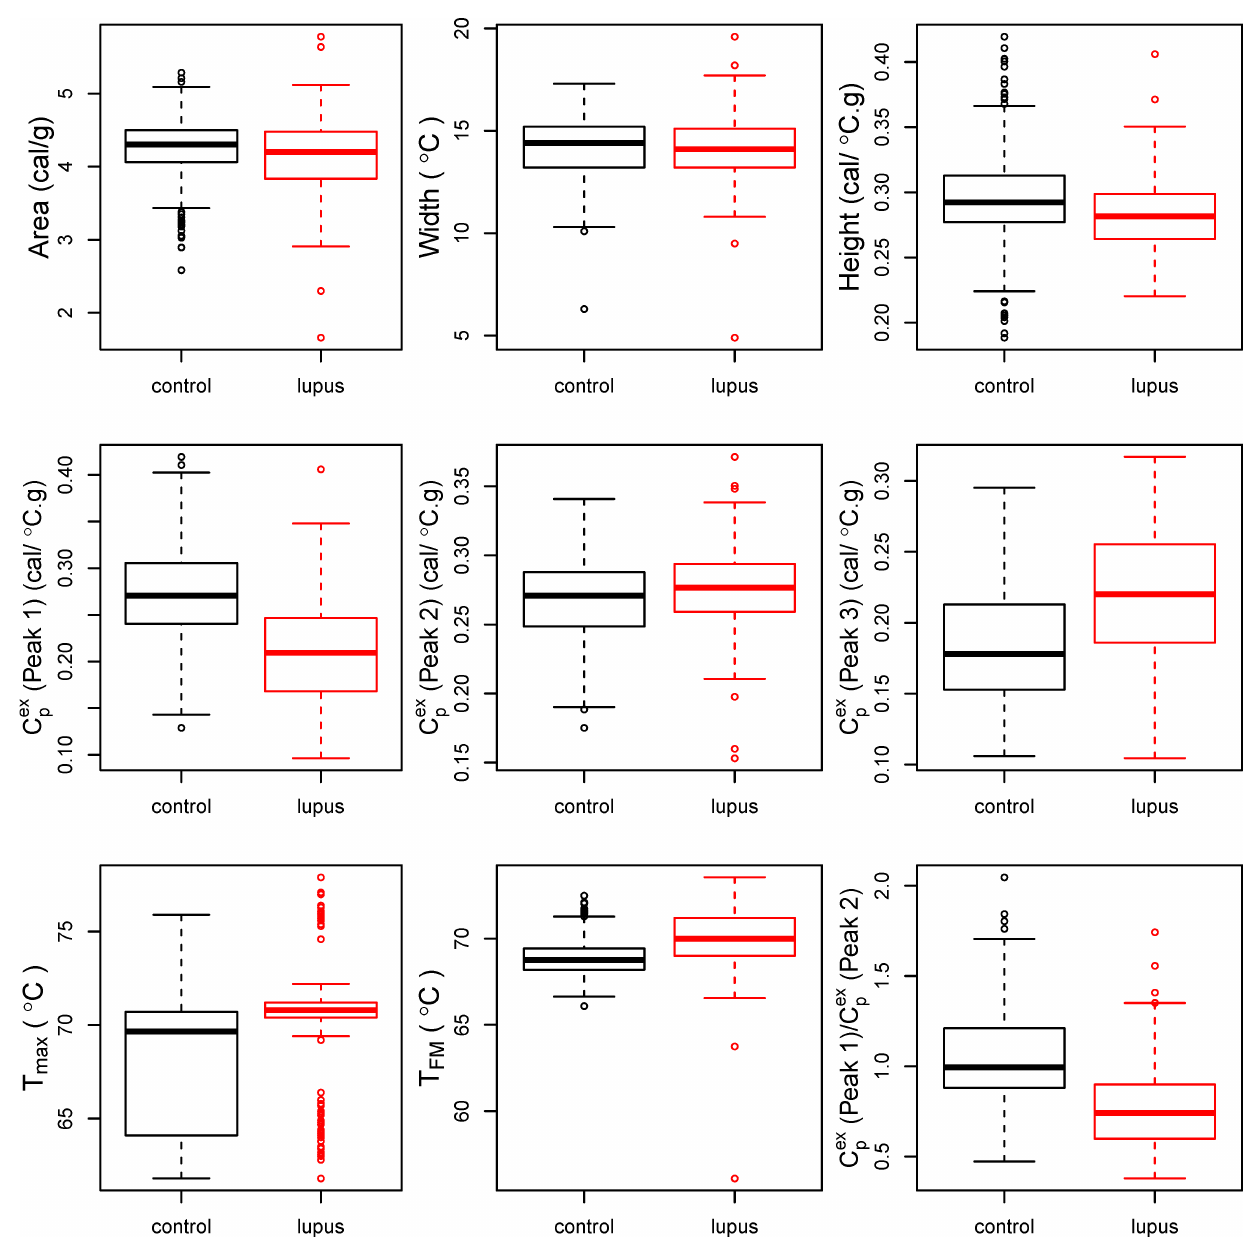
Fig 2. Boxplots of summarystatistics calculated for thermograms of lupus patients and controls. Top Row (from left to right): Total area under the curve, width at half height, and height at maximum temperature. Middle Row: Excess specific heat capacity ( C ex 67˚C), Peak 2 (69–73˚C),and Peak 3 (75–80˚C). Bottom Row: Temperature at the maximum peak (T max ), first moment temperature(T FM ), and ratio of C ex at Peak 1 to C ex at Peak p p